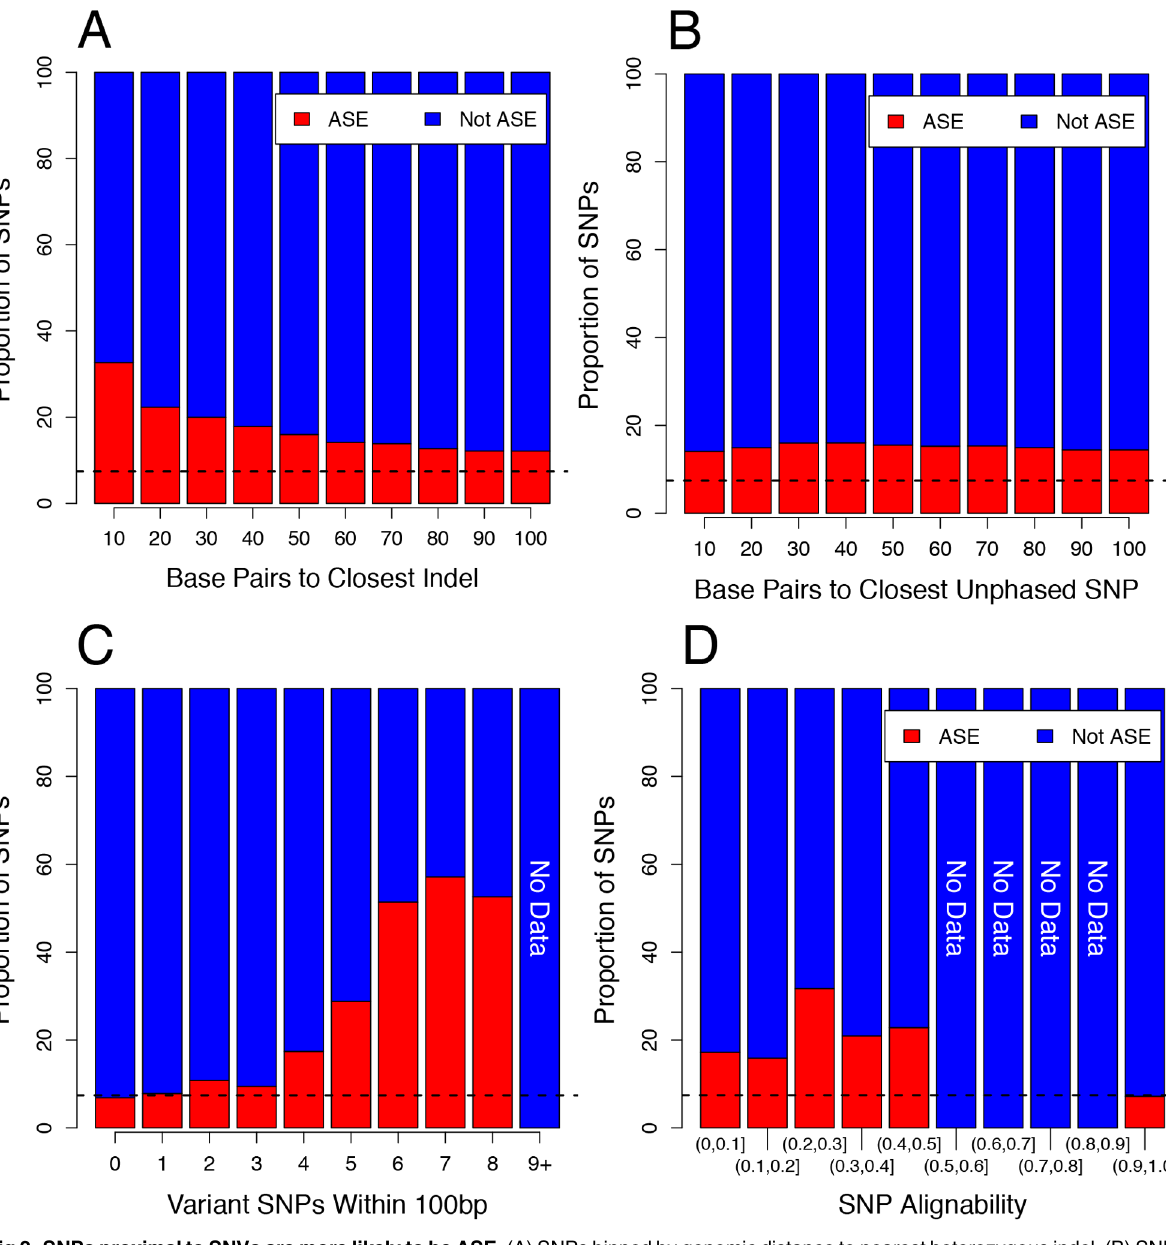
the highest WGS verification rate (S6d Fig). SNPs with low R 2 values were proportionally